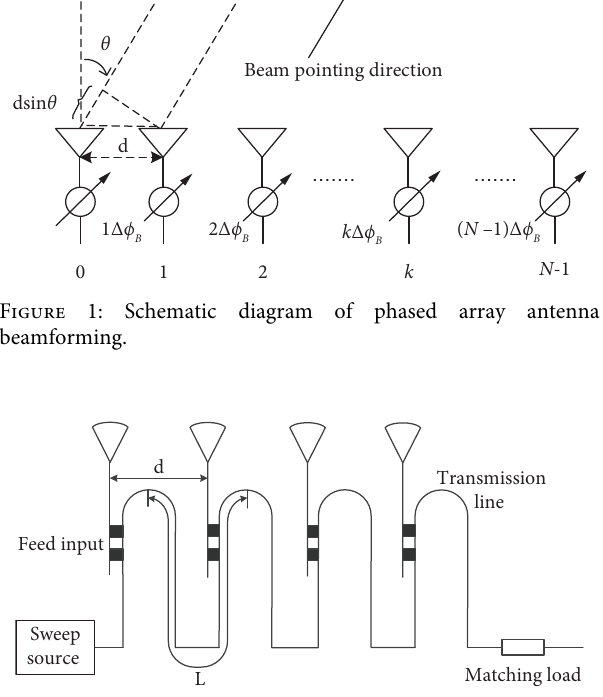
Figure 2: Frequency scanning